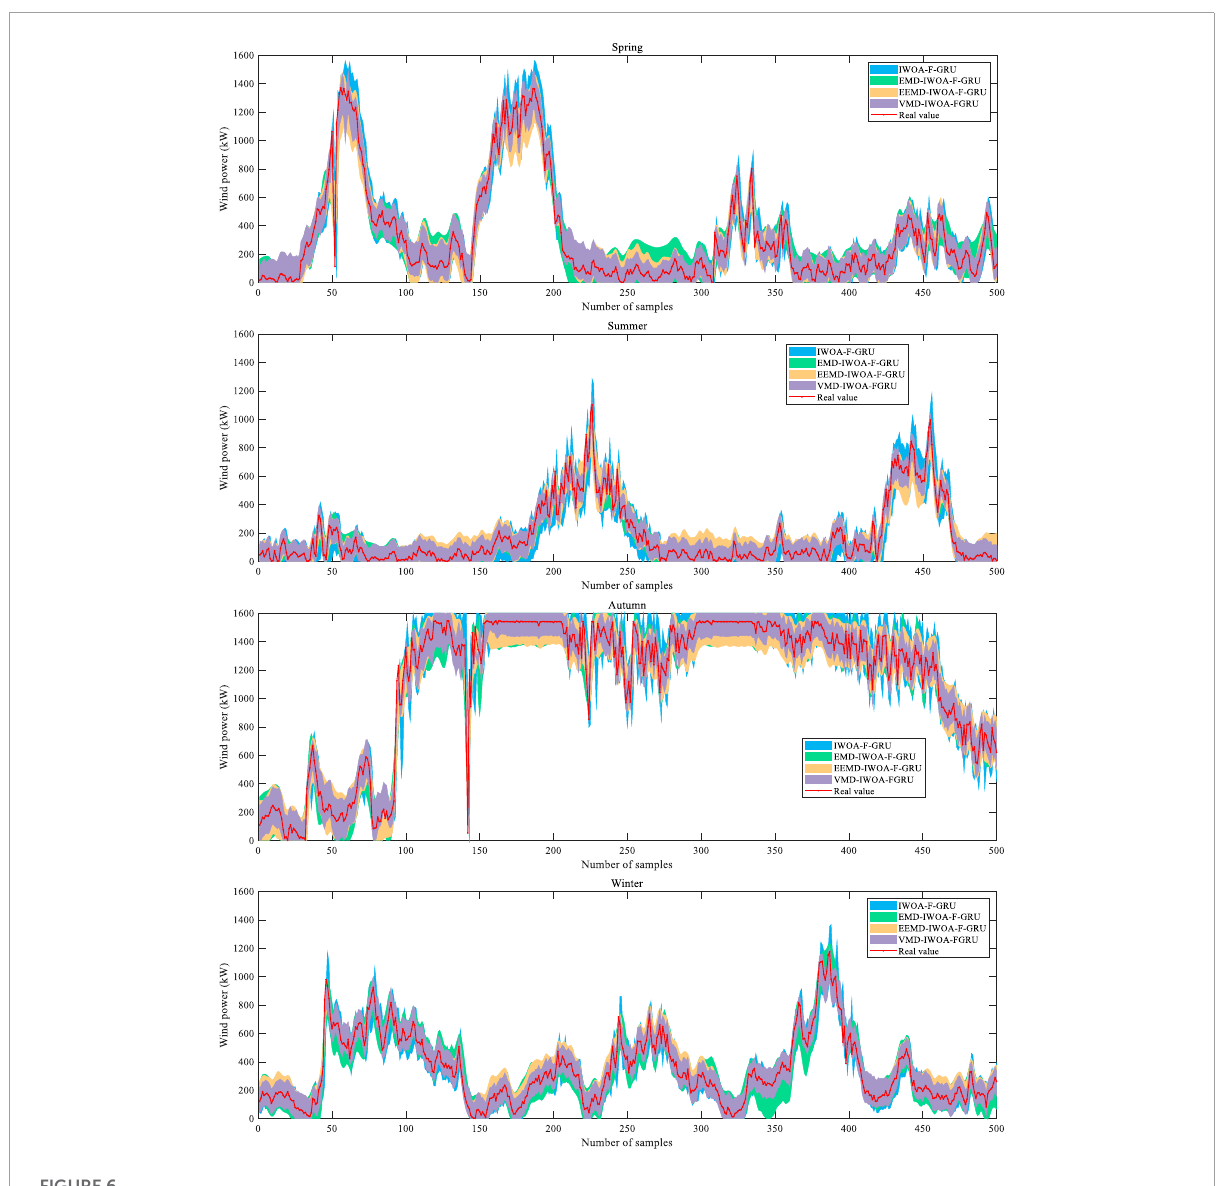
FIGURE 6 Prediction results of different models for four different